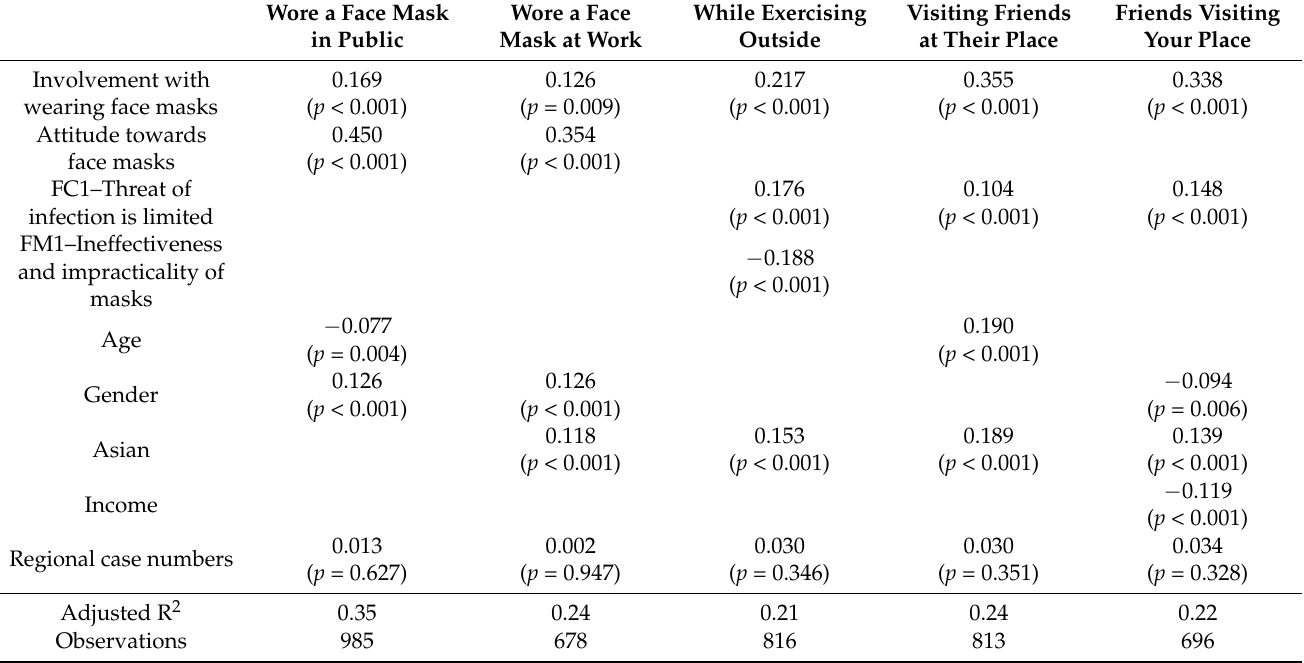
Table A1. Standardised parameter estimates from regressions for wearing face masks including number of regional COVID-19 infections.